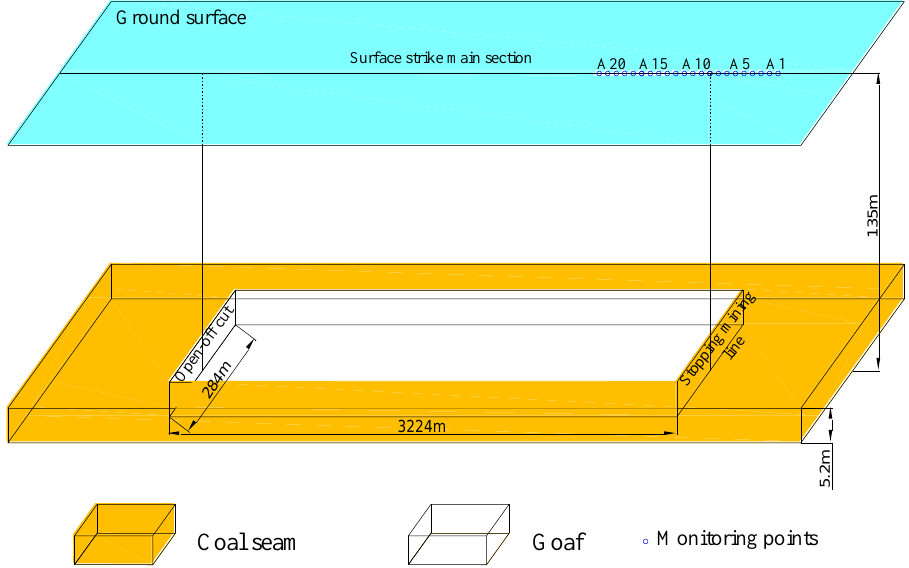
Figure 6. Overview of working face and layout of observation station. According to the geo-mining conditions and borehole histogram of working face 2407 (Figure 7), the lithology of the overlying strata in this working face is evaluated as medium-hard.